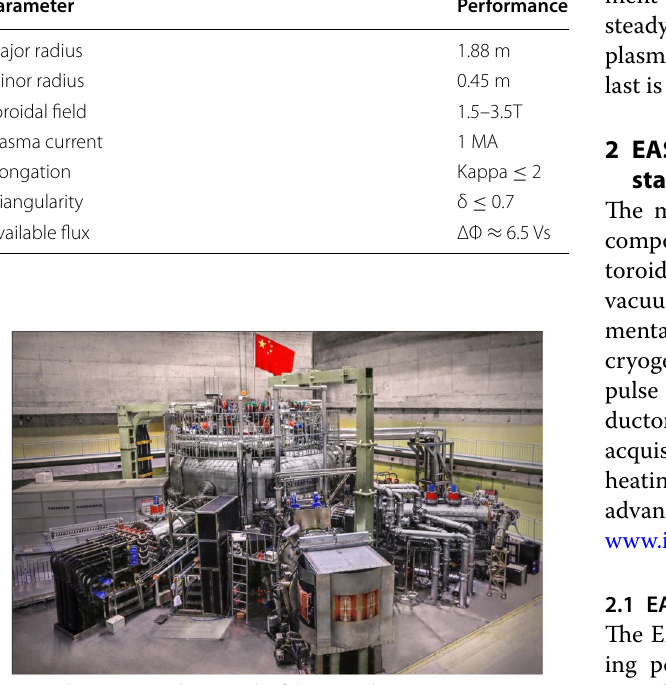
Fig. 1 The overview photograph of the EAST